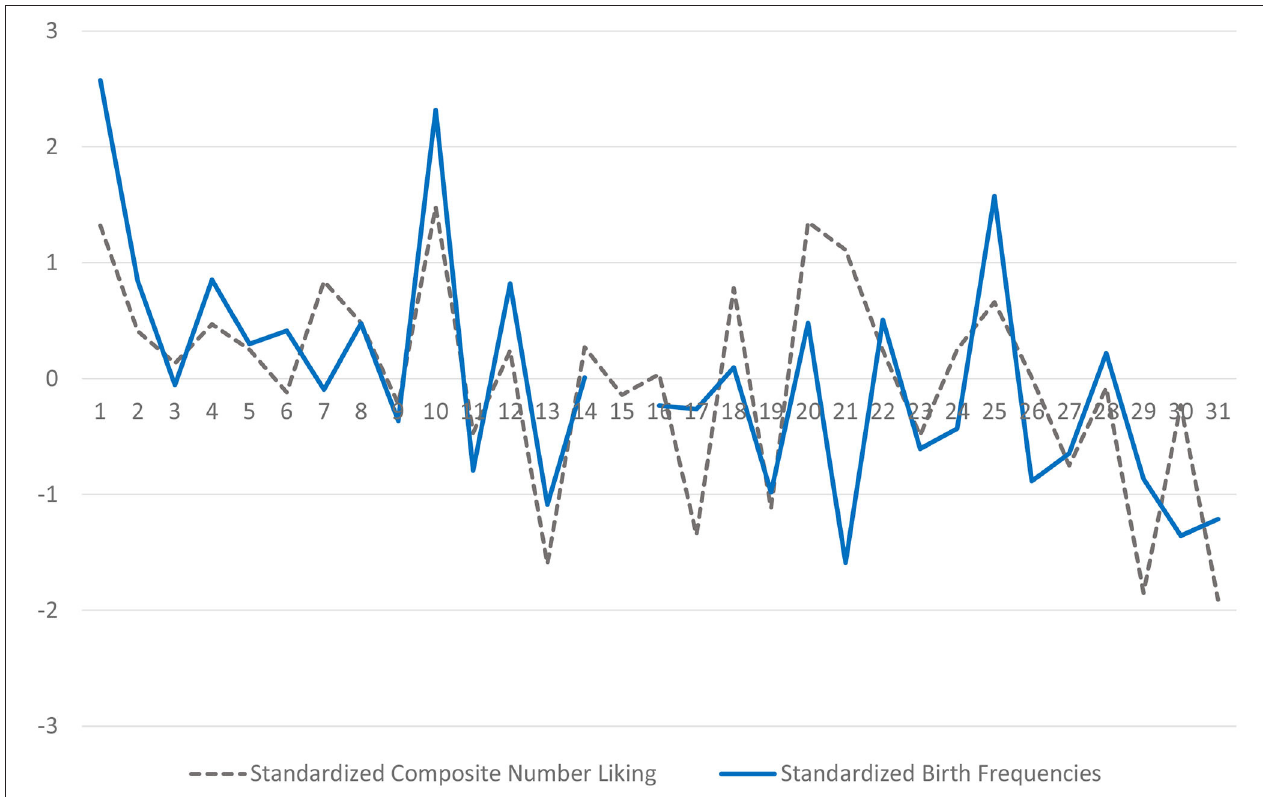
FIGURE 6 | Modern liking for calendar day numbers 1–31 (2013–2015) and SSDI birth frequencies (1890–1910). Day frequencies were corrected mathematically for their actual frequency, taking leap years into account for the 29th of the month. The low birth frequencies for the 29th and 31st of the month thus reflect a true aversion to these